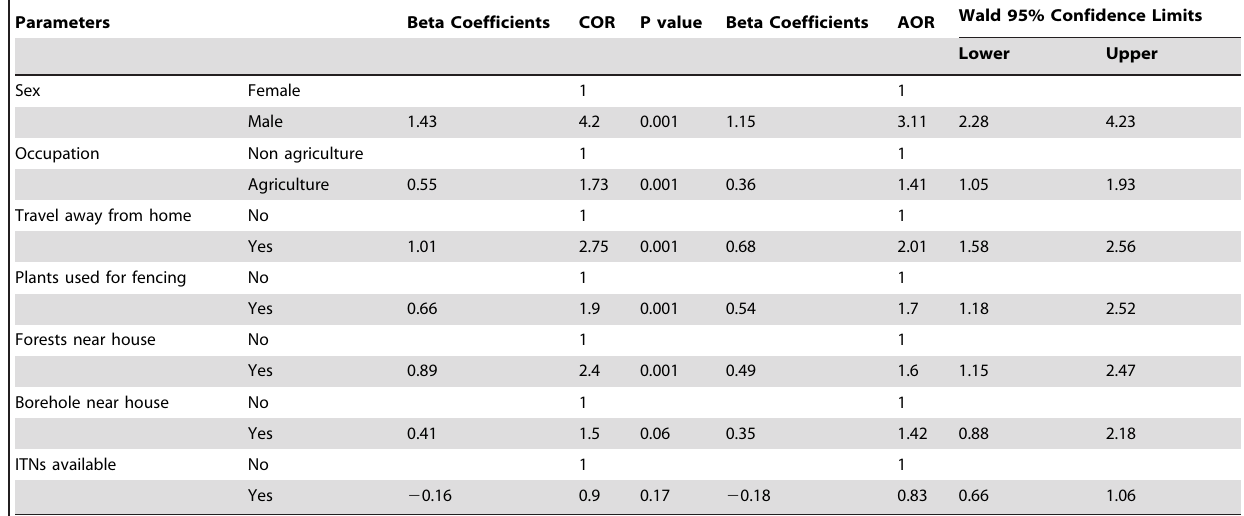
Table 5. Predictors of malaria transmission risk in high altitude villages of northwest Ethiopia, 2013.